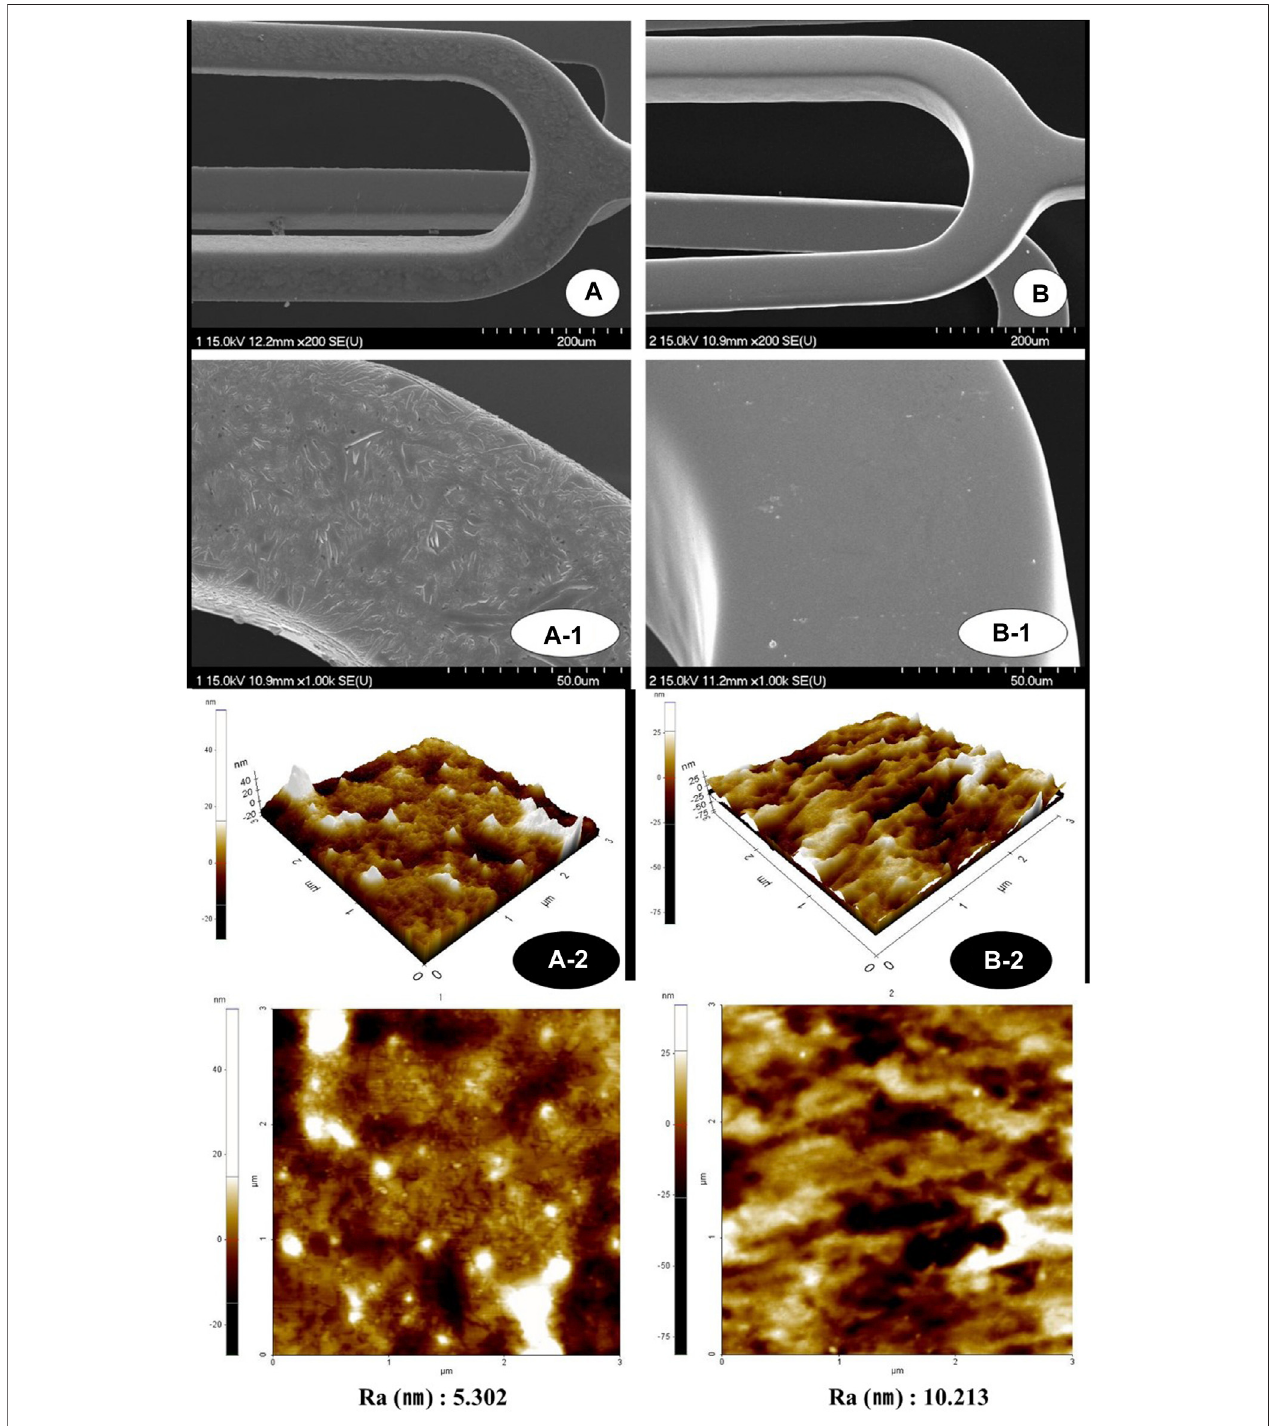
FIGURE 2 | Surface morphology images of NTM [ (A) ; × 200, A-1; × 1,000, A-2; 3 × 3 µm] and NT using AFM and scanning electron microscopy [ (B) ; × 200, B-1; × 1,000, B-2; 3 × 3 µm]. AFM, Atomic force microscopy; NTM, TiO2 fi lm – coated stent with mycophenolic acid; NT, TiO